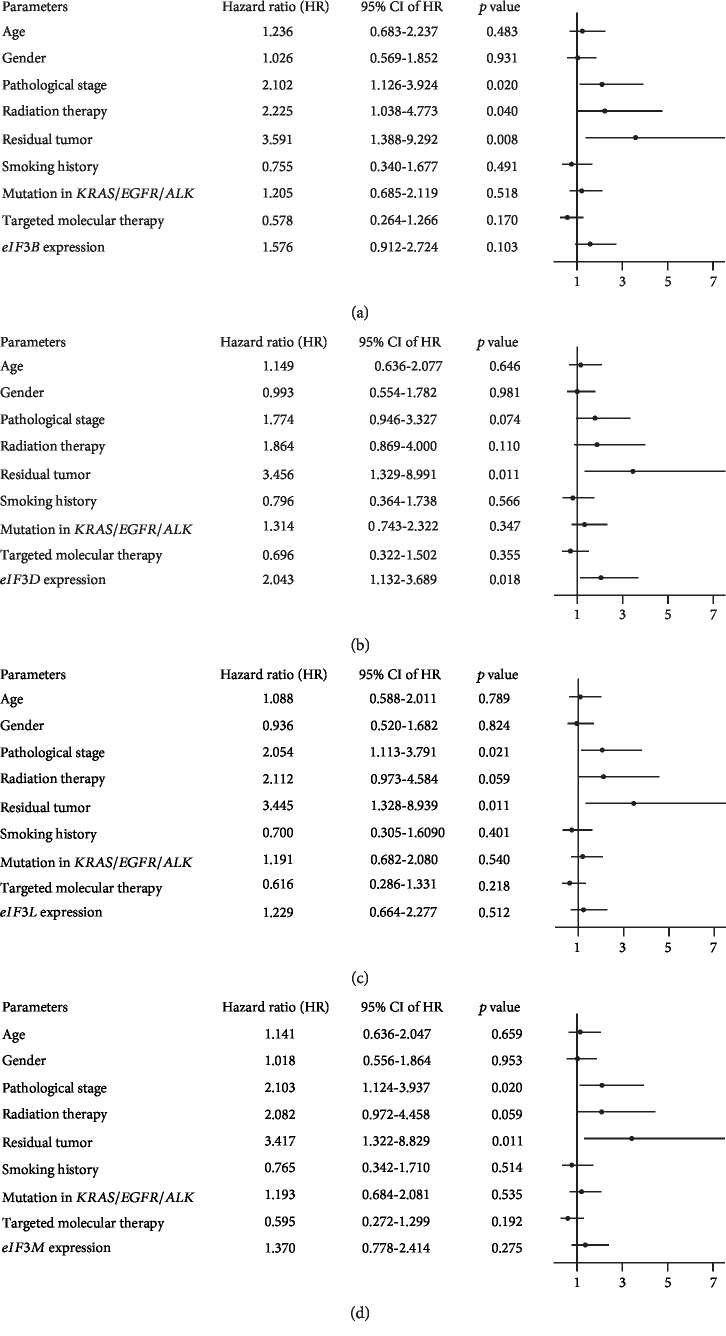
Forest plots for multivariate Cox regression models of four eIF3 subunits: (a) eIF3B; (b) eIF3D; (c) eIF3L; (d) eIF3M.